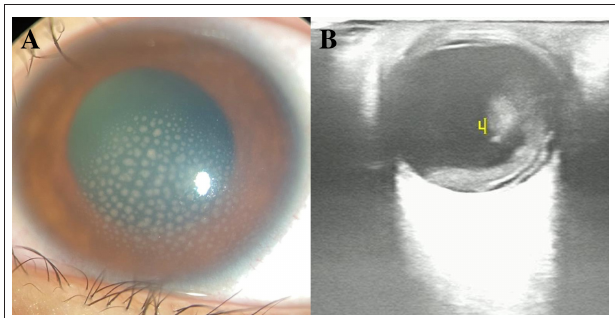
FIGURE 1 | (A) Slit-lamp examination revealed mutton-fat keratic precipitates in the middle and below the corneal endothelium and 3 + cells and 3 + flare in the anterior chamber. (B) Ultrasonography revealed severe vitreous opacity, posterior vitreous detachment in the left eye, and thickening of the posterior wall of the left